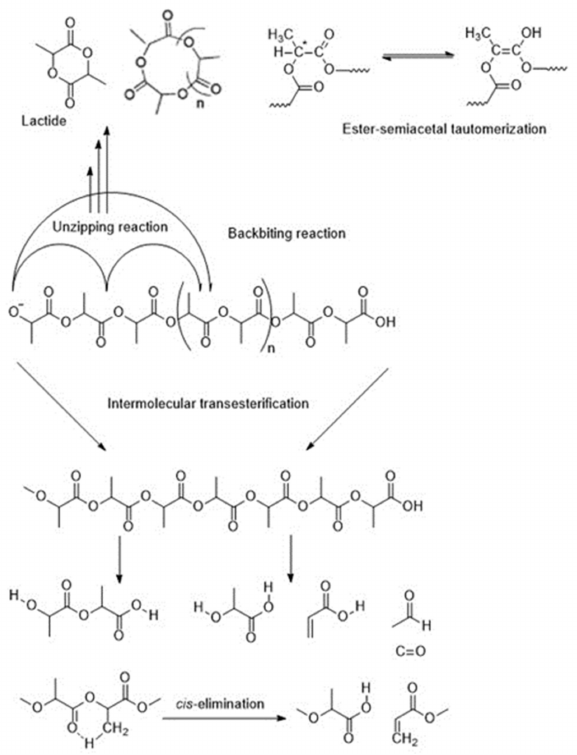
Figure 6. Thermodegradation PLA mechanisms adapted from